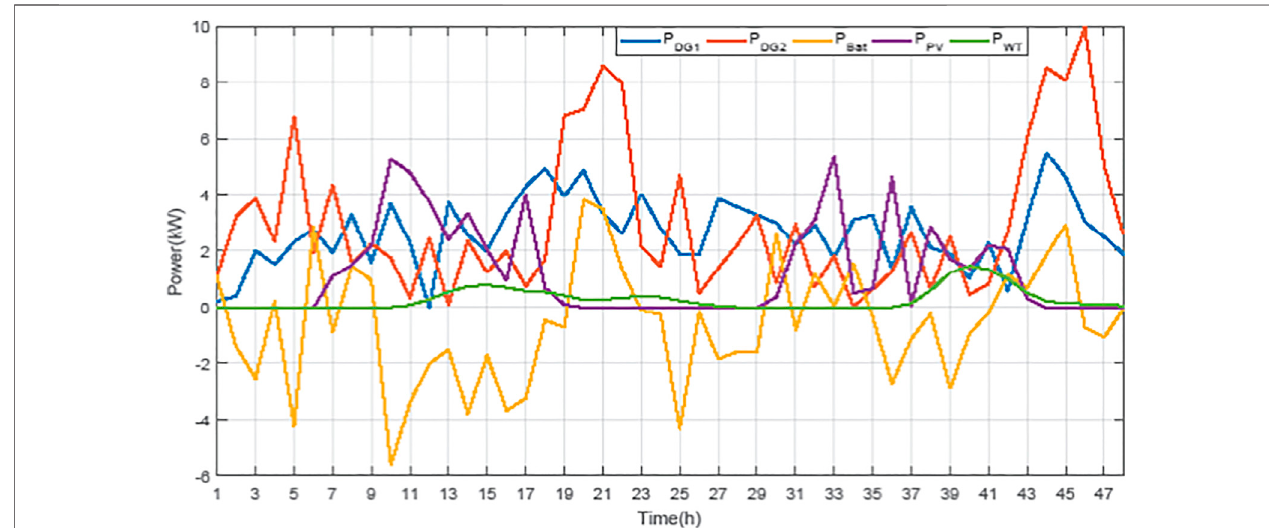
FIGURE 9 | Resulting ED solution of HG generation